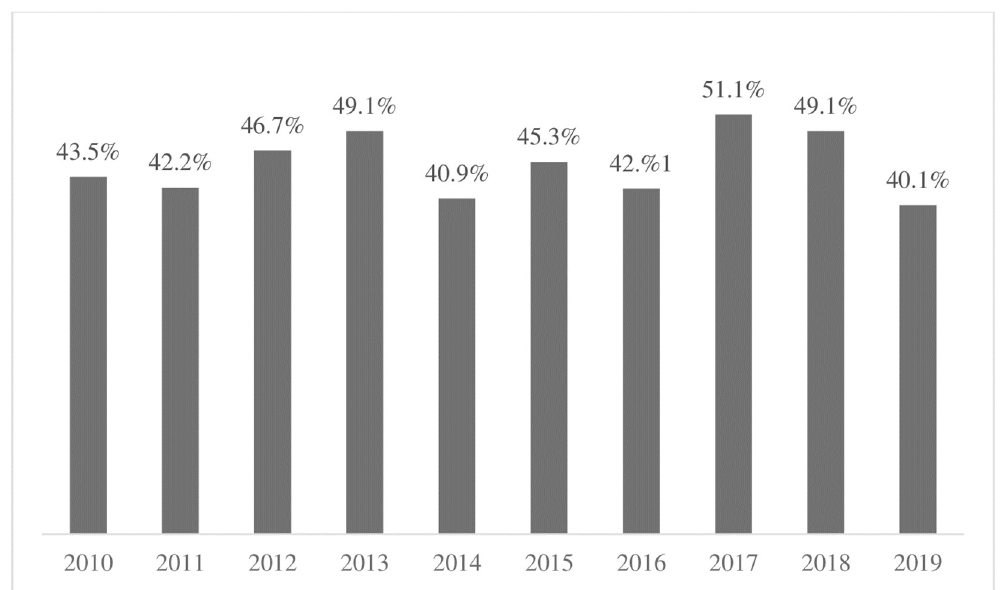
Fig 1. Approximate annual screening coverage among women age 25–64, Manaus, Brazil, 2010–2019. Approximate coverage = Number of cytology tests (screening and follow-up) processed at public laboratory among target population (1/3 of women age 25–64 in Manaus). Data sources: 2010 to 2013: SISCOLO / DATASUS; 2014 to 2016: SISCOLO-AM / DPCC (Local system). 2017 to 2018: SUS Outpatient Information System (SIA / SUS); 2019: Manaus Cytopathology Laboratory -SEMSA- Manaus (considering only Pap tests for screening).